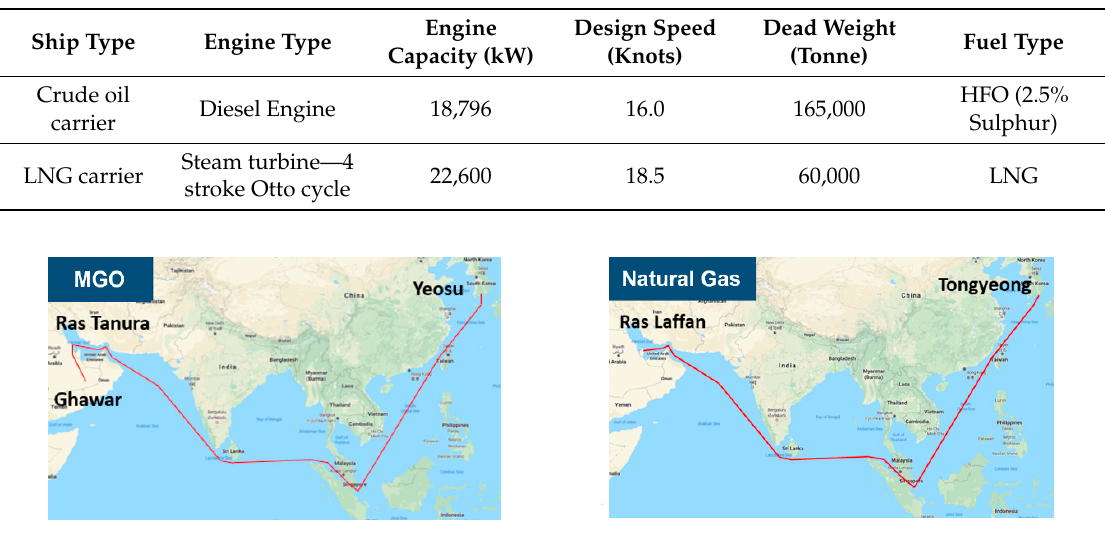
Table 4. Trip scenario of 12,000 gross tonne (GT) coast ferry.